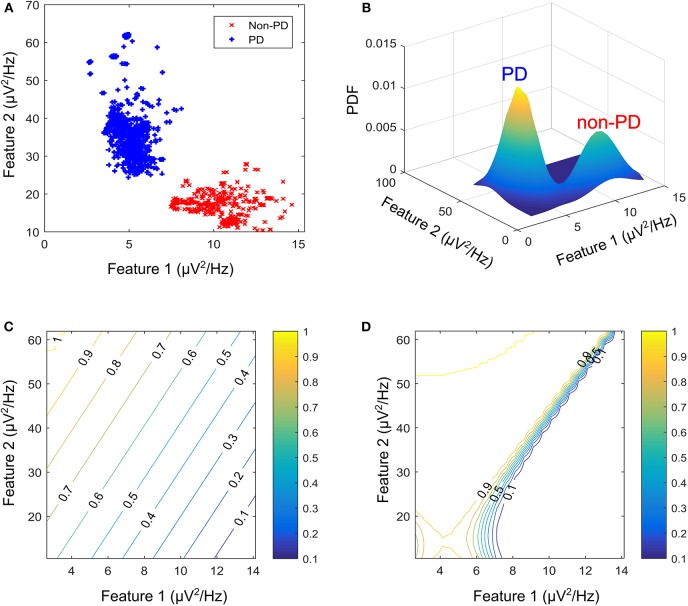
Contour plot for state estimates over a feature space for the machine learning models. (A) Example feature space showing PD and non-PD examples for dataset C. (B) Probability density function (PDF) for PD and non-PD training examples in (A). (C) Contour plot for state estimates using SVM, with a range from 0 to 1 representing levels of severity from non-PD to PD for (A). (D) Contour plot for state estimates using GMM, with a range from 0 to 1 representing levels of severity from non-PD to PD for (A). The two features are, Feature 1 (21–26 Hz band) and Feature 2 (18–23 Hz band).